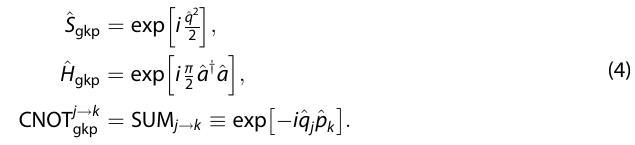
(cid:3) (cid:4) (cid:3) of the approximate GKP quantum state of n ¼ 5